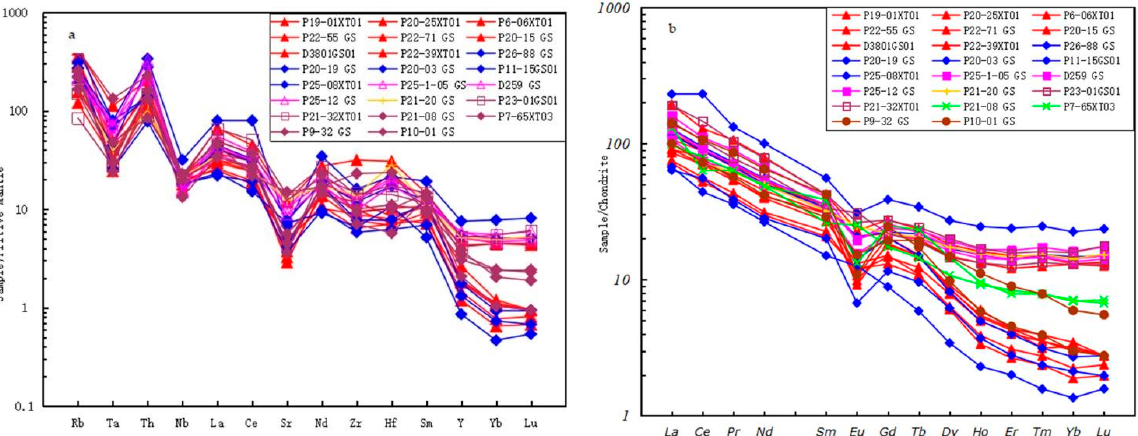
Figure 5. ( a ) Primitive mantle-normalized multi-elemental plots (normalizing values from [17]) and( b ) chondrite-normalized rare earth element (REE) patterns for the Dahongliutan pluton samples (normalizing values from [18]). Table 2. Trace (× 10 − 6 ) and rare earth element (× 10 − 6 ) contents of Dahongliutan granite samples. Sample